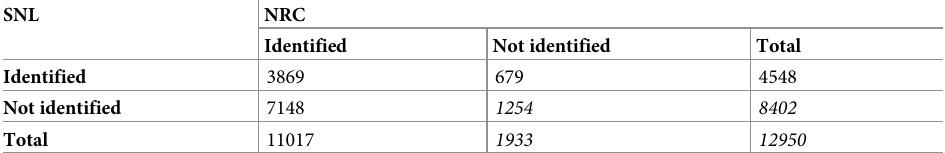
NRC: National Reference Center; SNL: Sentinel Network of Laboratories. In italics: numbers estimated by capture- recapture using Chapman’s formula [15].